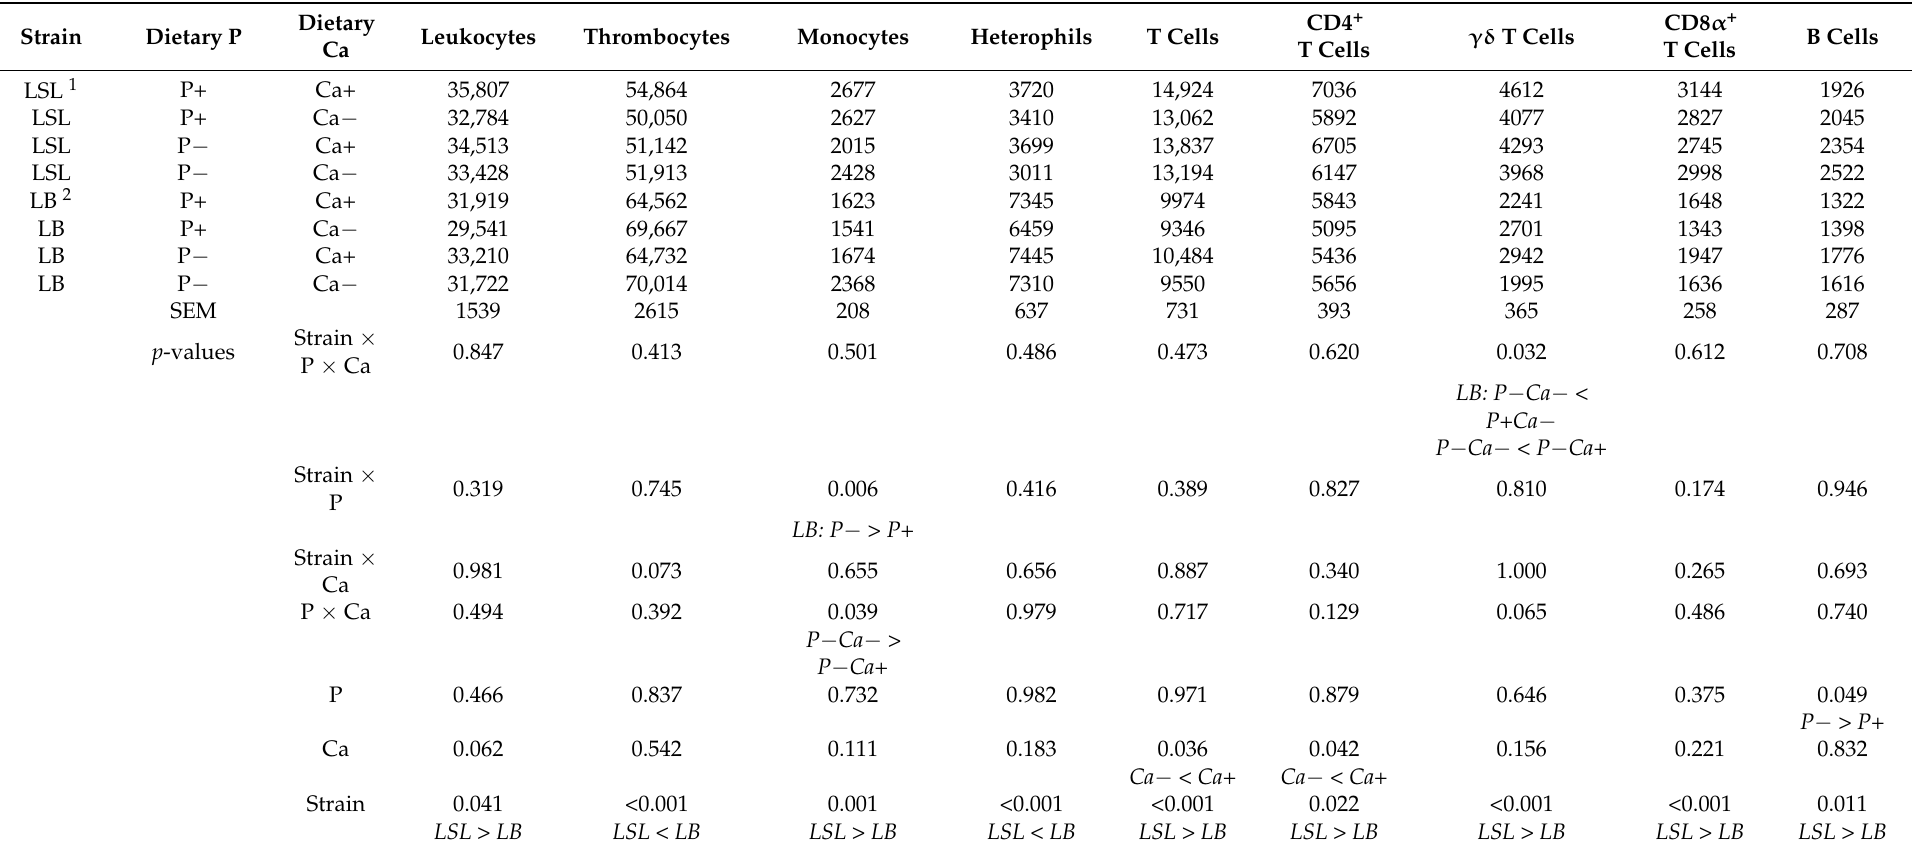
Table 1. Effect of strain, dietary P and Ca on the number of immune cells (#/ µ L) in whole